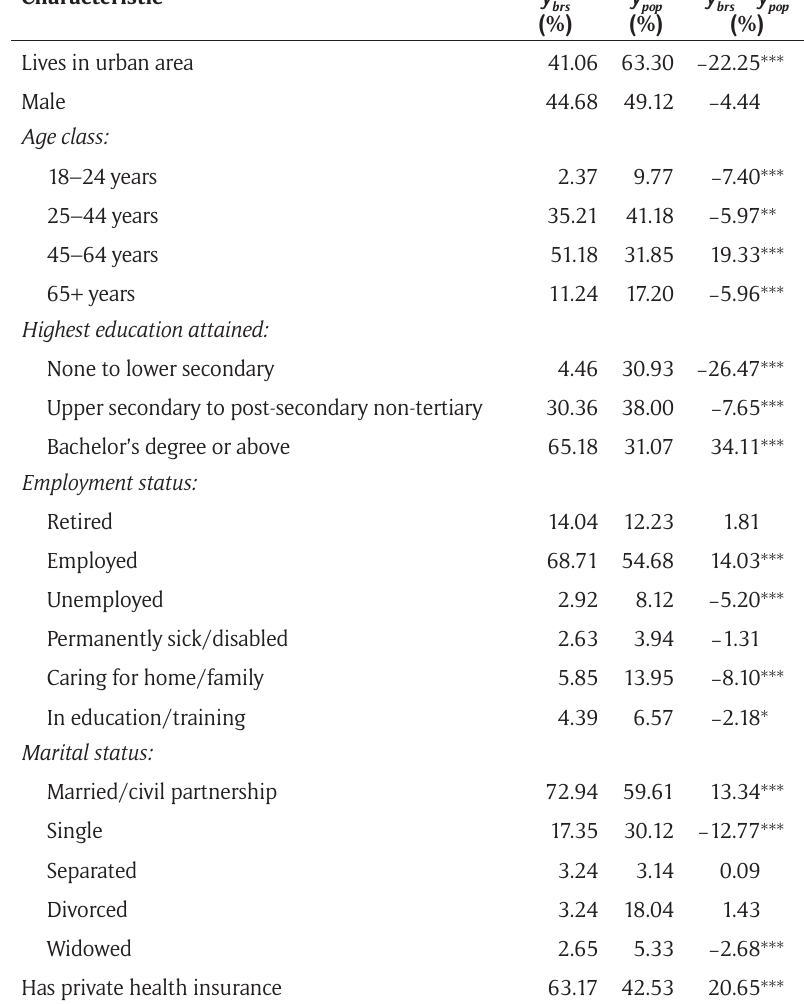
Table 1: Demographic characteristics of biodiversity recorders compared with adult population in Ireland using Healthy Ireland Survey.